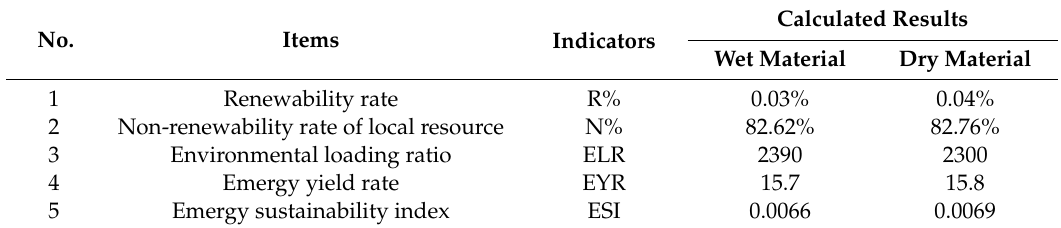
Table 20. All the indicators of the emergy assessment for cement